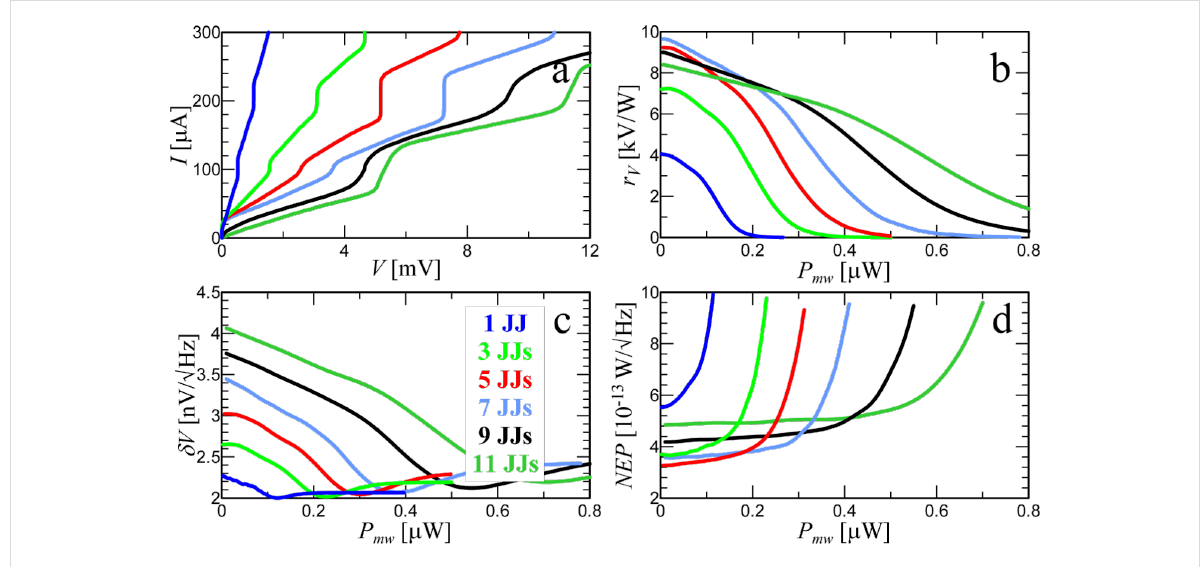
Figure 7: (a) IVCs for different numbers of JJs from one to eleven under a MW signal with power P MW = 3 μ W and frequency F MW = 250 GHz. (b) Responsivity, (c) output voltage noise, and (d) NEP are shown depending on the power of the external signal at an operating point I = 98 μ A.